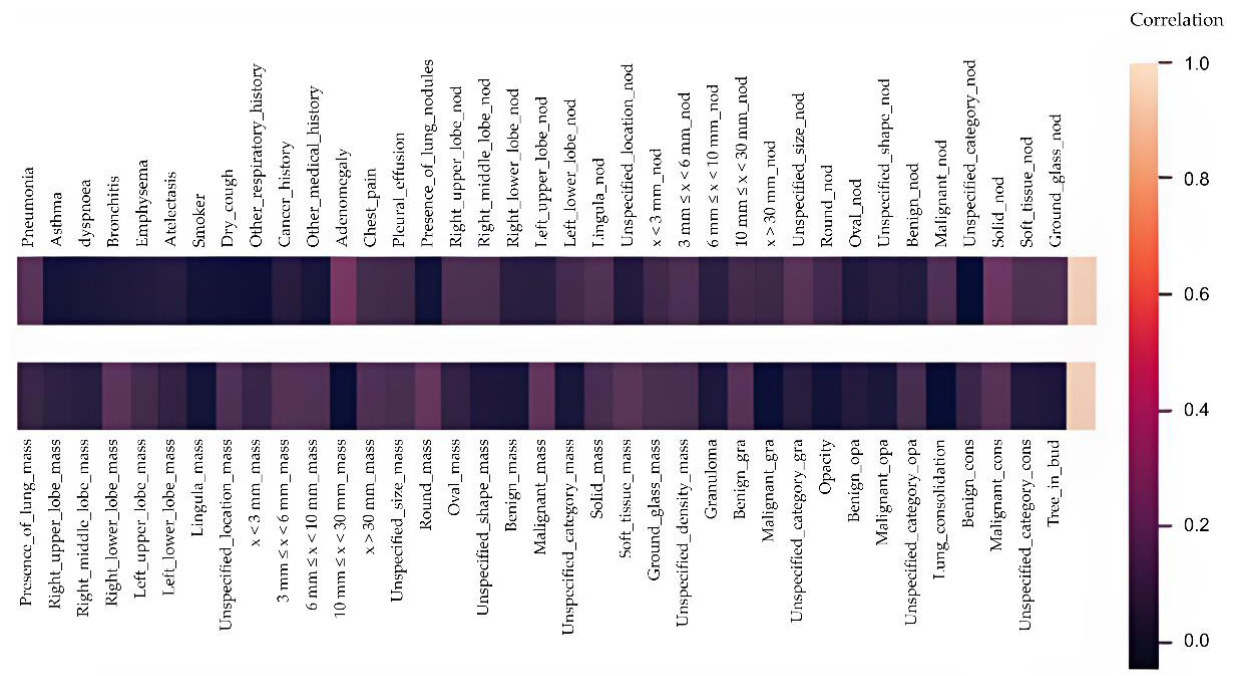
Figure 13. Correlation matrix of CDEs against cancer.